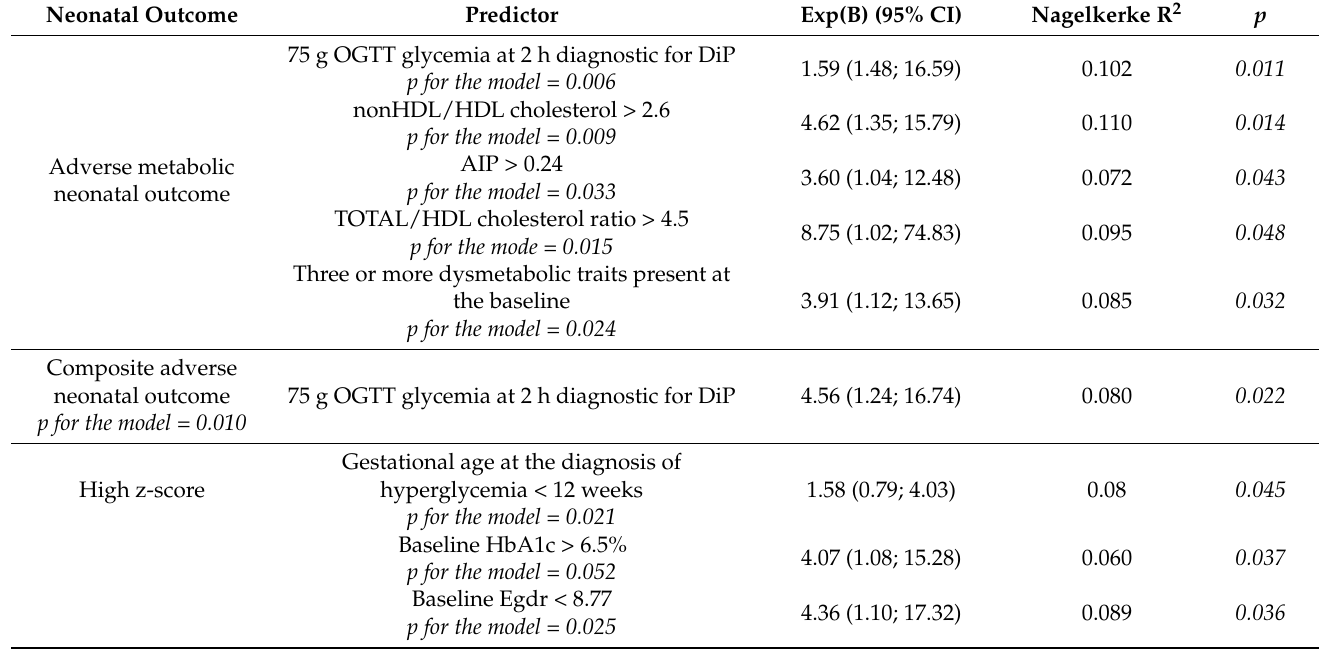
Table 3. Maternal characteristics and markers of insulin resistance as predictors of the neonatal outcomes in the study group; data from the univariate logistic